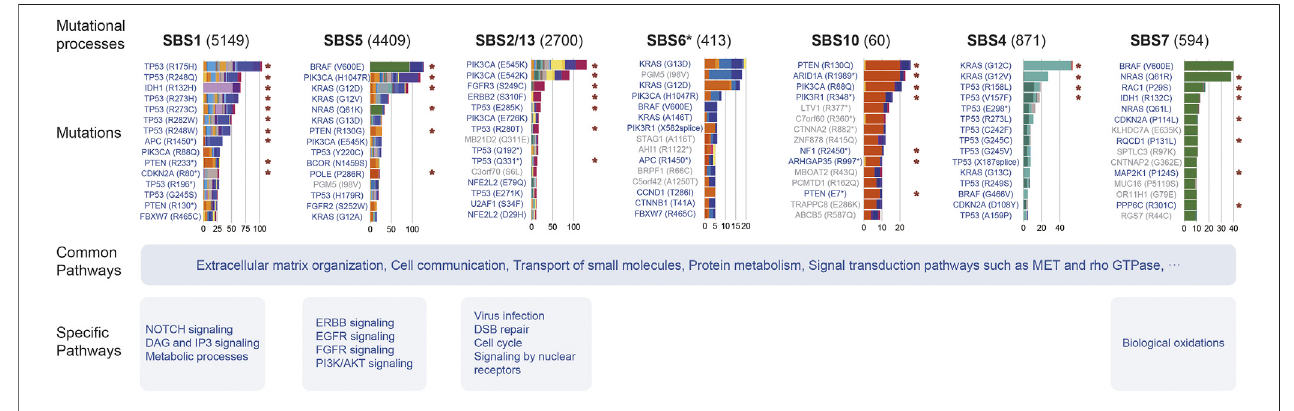
FIGURE 6 | Summary of the effect of mutational processes. This picture exhibits the top 15 mutations and pathways affected by several mutational processes. Barplotshowsthemutationnumberinducedbythemutationalprocess, andthe fi lledcolorofthebarindicatesthecancertypeorsubtype.Theredasteriskindicatesthe speci fi c relationship identi fi ed by Results in at least one cancer type. Mutations marked blue are mutations in cancer genes and gray are passenger mutations.